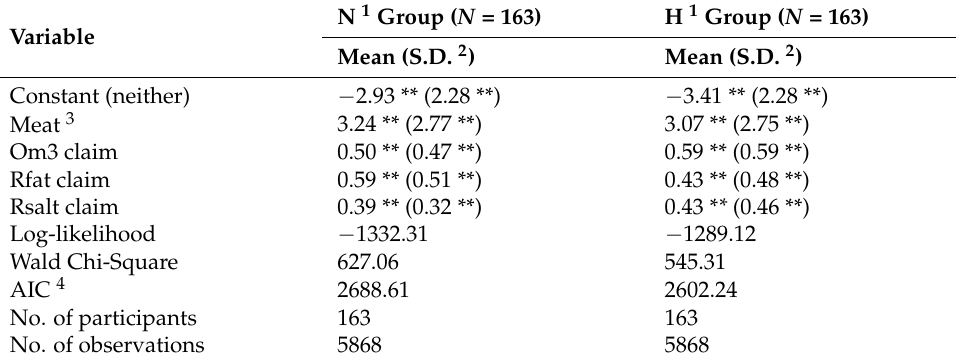
Table 4. Means and 95% confidence intervals of WTP